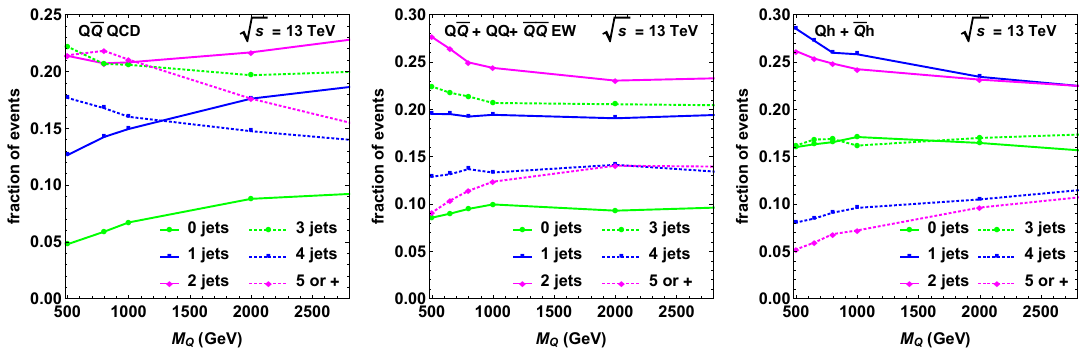
Figure 11 . Fraction of selected signal events featuring a given number of AK4 jets that are not originating from a Higgs-boson decay. We separately consider QCD-induced (left panel) and EW- induced (middle panel) VLQ pair production, as well as associated Higgs and VLQ production (right panel).